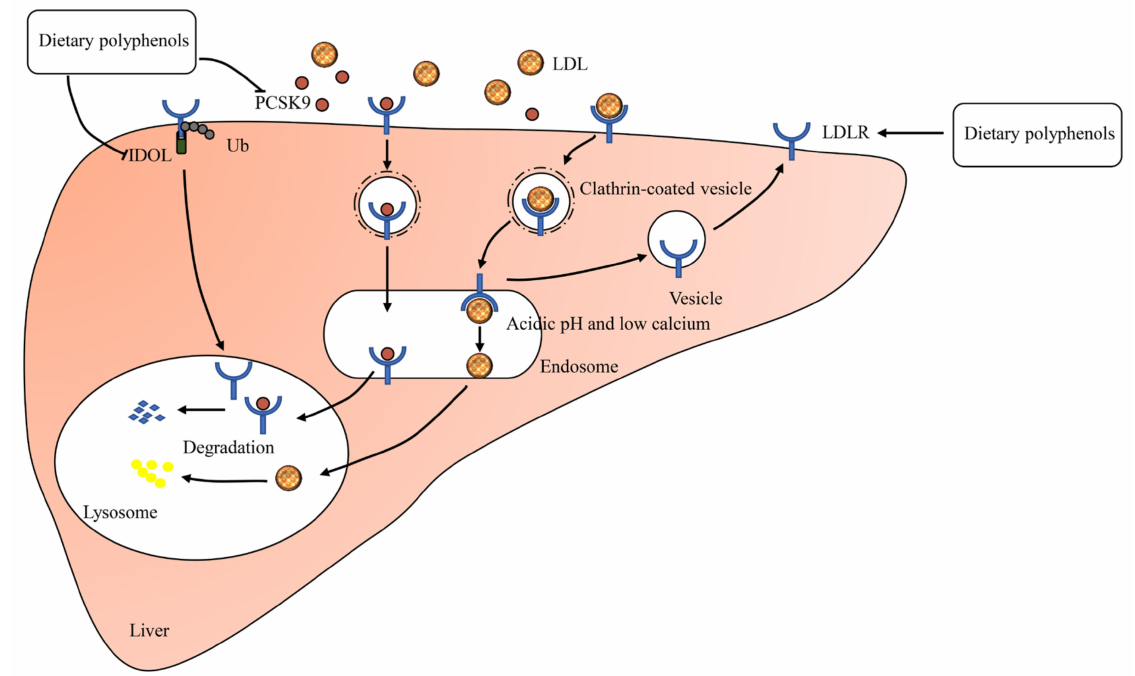
Figure 4. The regulatory mechanisms of LDL endocytosis. PCSK9, proprotein convertase subtilisin/kexin type 9; IDOL, inducible degrader of the LDLR; Ub,